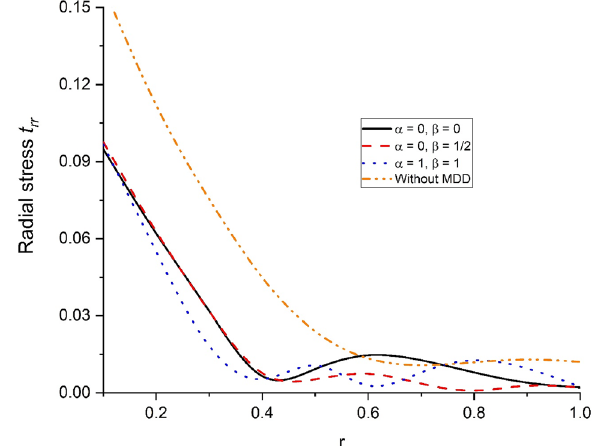
Fig. 6 Variations of radial stress t rr with radius